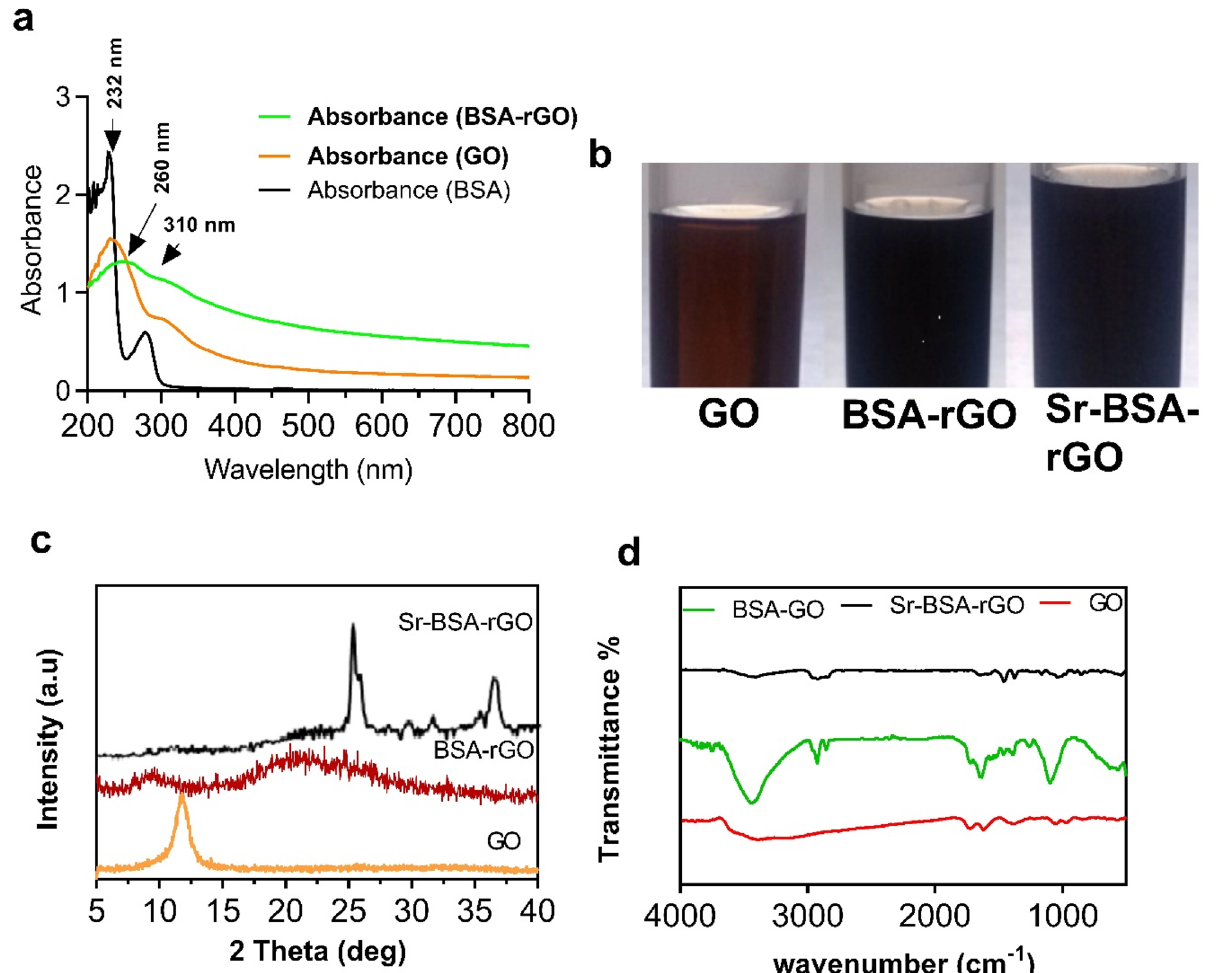
Figure 2. Characterization of Sr-BSA-rGO nanosheets. ( a ) The UV–Vis spectrums of BSA, GO and BSA-rGO dispersed in deionized water (concentration: 0.1 mg/ml). ( b ) Images of the synthesized GO, BSA-rGO and Sr-BSA-rGO. ( c ) and ( d ) XRD and FTIR profiles of GO, BSA-rGO and Sr-BSA-rGO nanosheets